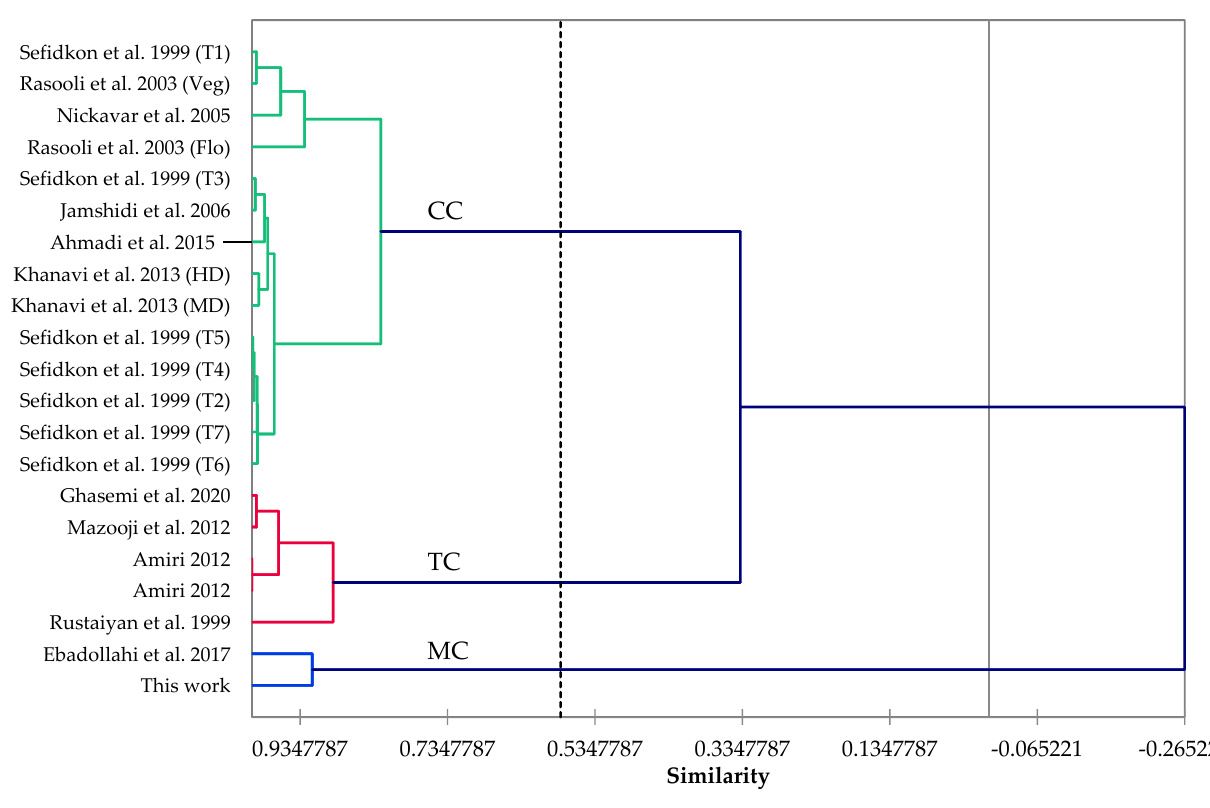
Figure 1. Dendrogram obtained by cluster analysis of the percentage composition of essential oils from Thymus kotschyanus samples, based on the correlation and using the unweighted pair-group method with arithmetic average (UPGMA). CC: Carvacrol chemotype. TC: Thymol chemotype and MC: Mixed ( α -terpinyl acetate/ α -terpineol/linalyl acetate/linalool) chemotype. Amiri 2012 [26], Sefidkon et al. 1999 [36], Khanavi et al. 2013 [37], Rasooli et al. 2003 [38], Nickavar et al. 2005 [39], Jamshidi et al. 2006 [40], Ahmadi et al. 2015 [41], Ghasemi et al. 2020 [42], Mazooji et al. 2012 [43], Rustaiyan et al. 1999 [44], Ebadollahi et al. 2017 [45].